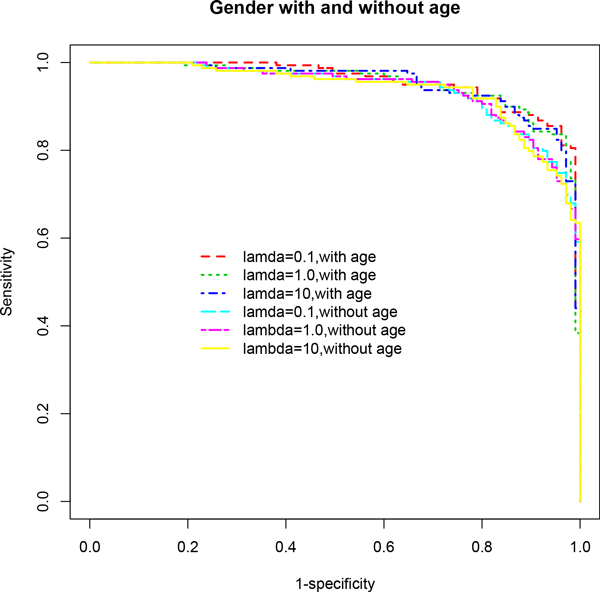
ROC curves based on multivariable stepwise penalized logistic regression models (stepPLR) adjusting for gender effect. Models that are also adjusted for age effect outperformed those that did not control for age, across all choices of the parameter λ. The age-adjusted final model for λ = 0.1 showed the best performance in terms of AUC. See Table 1 for detailed results and the text for discussion of these results.